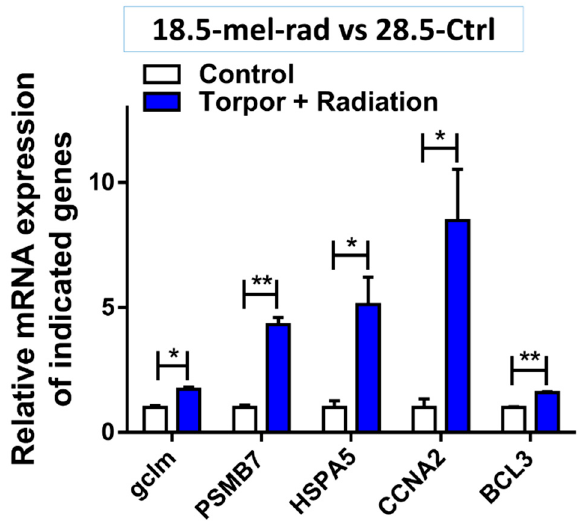
Figure 8. Validation of gene expression in the torpor + radiation (18.5-mel-rad) group compared with control (28.5-Ctrl). The figure shows the increase in expression of GCLM ( p = 0.011), PSMB7 ( p = 0.004), HSPA5 ( p = 0.035), CCNA2 ( p = 0.036) and BCL3 ( p = 0.001911), relative to the control (28.5-Ctrl) involved in glutathione metabolism, proteasome complex, protein refolding, cell cycle and anti-apoptosis, respectively. * p < 0.05, ** p < 0.001.